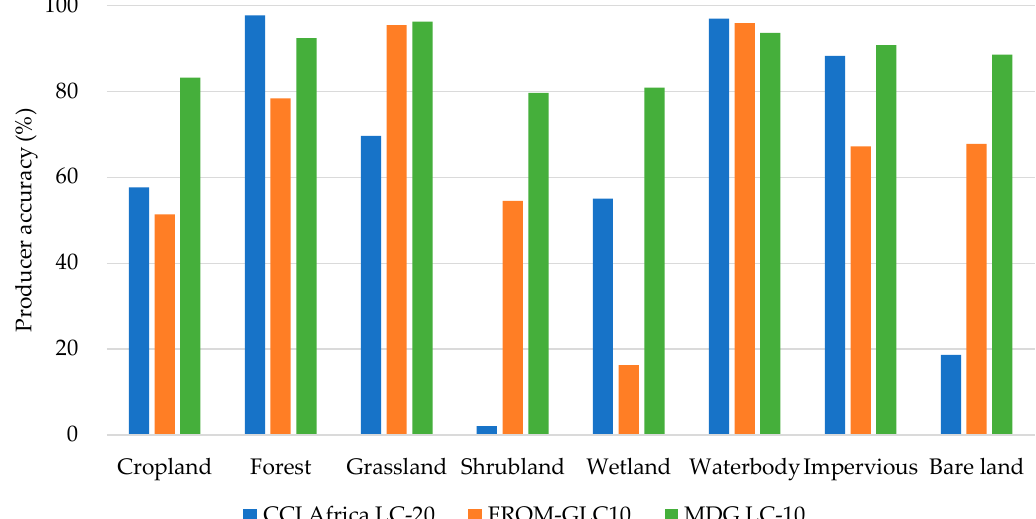
Figure 5. Statistical comparison of producer accuracies (PAs) of the available high-resolution land cover maps for Madagascar and the map produced in this study.